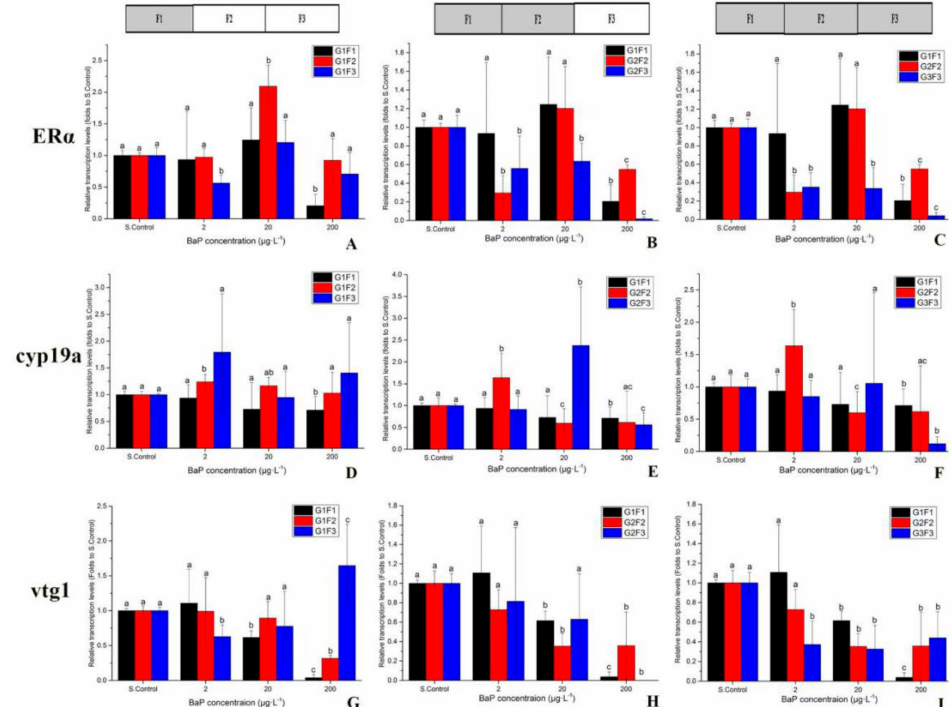
Figure 3. The mRNA levels of the genes in embryos after exposure to BaP for 5 d pf . Bars with di ff erent letters indicate statistical significance ( p < 0.05) as assessed using one-way ANOVA followed by the LSD test. ( A – C ) ER α gene expression at di ff erent exposure patterns; ( D – F ) cyp19a gene expression at di ff erent exposure patterns; ( G – I ) vtg1 gene expression at di ff erent exposure